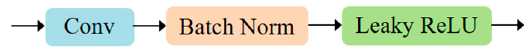
Figure 5. Composition of the CSP1_X block . Figure 6. Composition of the residual unit block . Figure 7. Composition of the CSP2_X block . Figure 8. Composition of the SPP block . 3.3. Attention Feature Fusion Block In combination with the multi-scale channel attention block proposed above, we pro- pose AFFB, which can better capture contextual information from different network layers by fusing semantic and scale-inconsistent features and thus achieve better object detec- tion. Figure 9 is a structure diagram of the AFFB. Due to the presence of the multi-scale channel attention block, the output